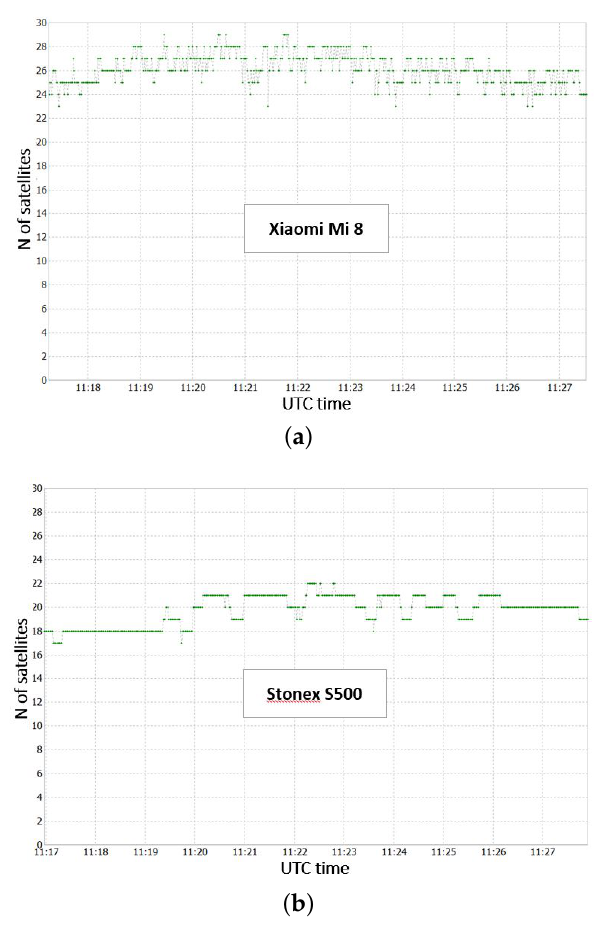
Figure 4. Number of satellite observed by Xiaomi Mi 8 receiver ( a ) and Stonex S500 receiver ( b